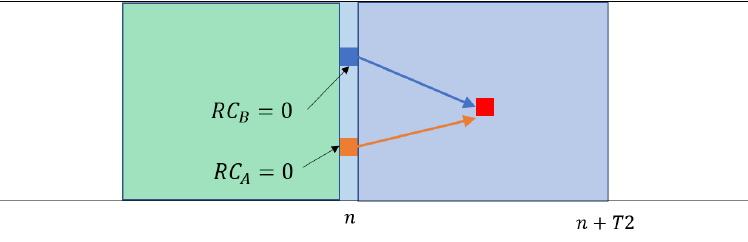
Figure 4. Collision is not detected by the UEs using the same